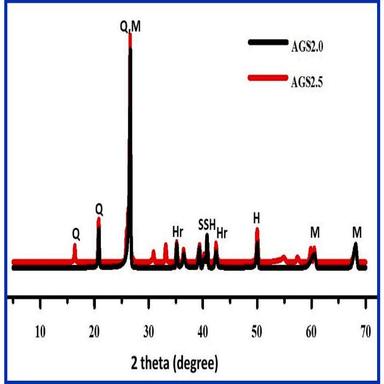
XRD spectra of geopolymer compositions after addition of amorphous silica in geopolymer mix AG1.0.